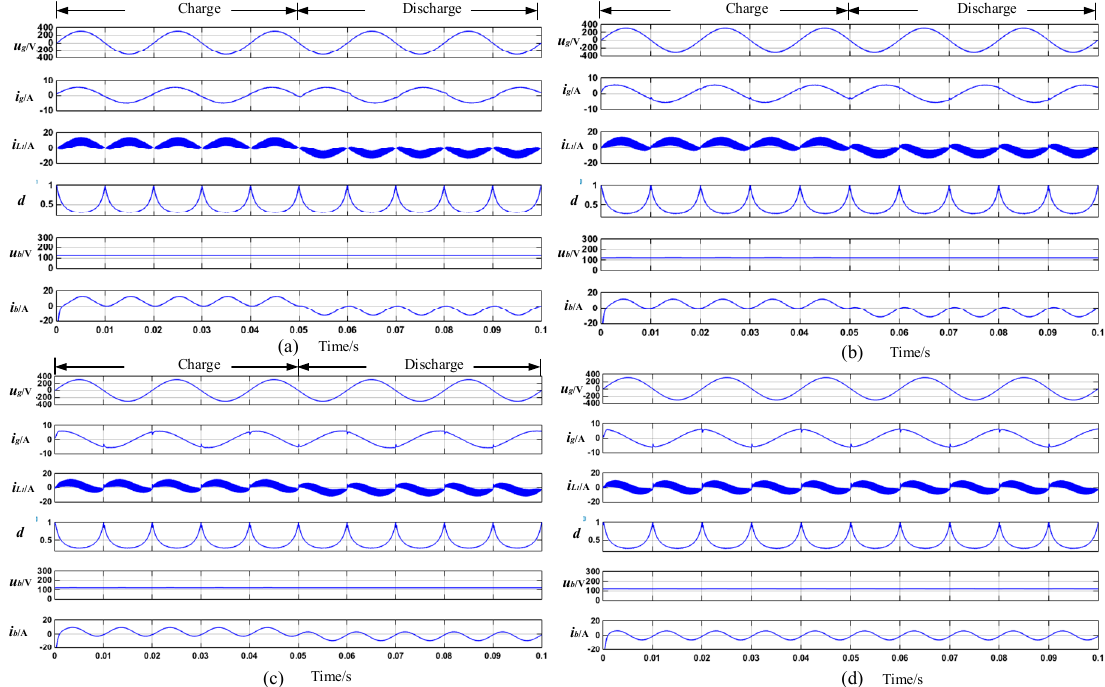
Figure 7. The presented converter charge or discharge at different power factors: ( a ) Unity power ±√ factor; ( b ) power factor: cos ϕ = 3/2; ( c ) power factor: cos ϕ = ± 0.5; ( d ) power factor: cos ϕ = factor; ( b ) power factor: (cid:1855)(cid:1867)(cid:1871)(cid:2030) = ±√3/2 ; ( c ) power factor: (cid:1855)(cid:1867)(cid:1871)(cid:2030) = ±0.5 ; ( d ) power factor: (cid:1855)(cid:1867)(cid:1871)(cid:2030) = 0 .